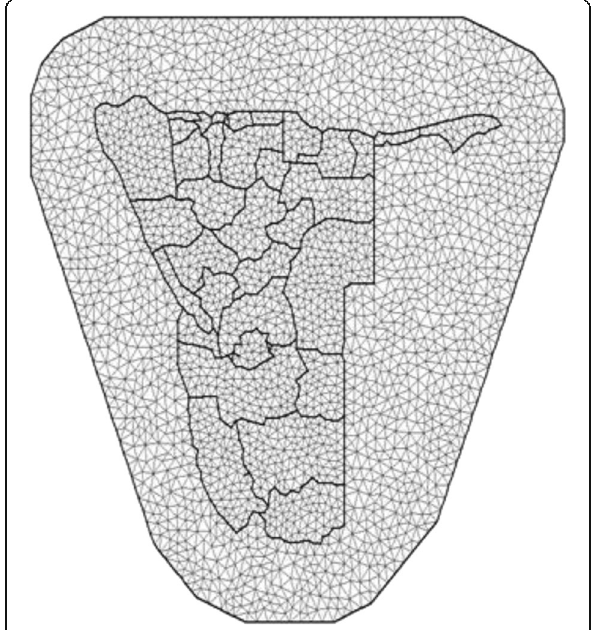
Fig. 1 Convex hull meshes: Constrained refined Delaunay triangulation